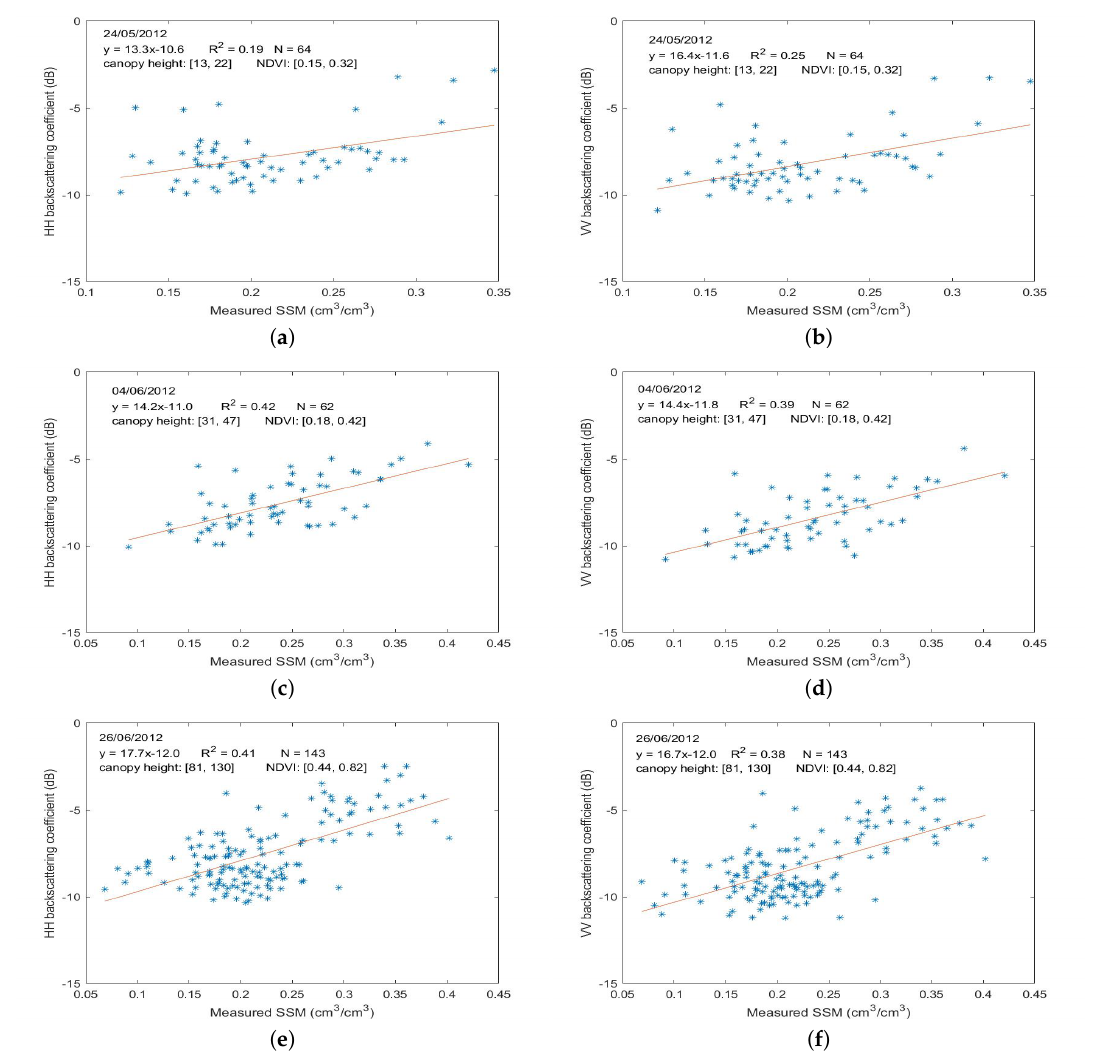
Figure 4. Backscattering coefficients as a function of SSM for corn cover. ( a ) Emergence stage, HH polarization; ( b ) Emergence stage, VV polarization; ( c ) Trefoil stage, HH polarization; ( d ) Trefoil stage, VV polarization; ( e ) Jointing stage, HH polarization; ( f ) Jointing stage, VV